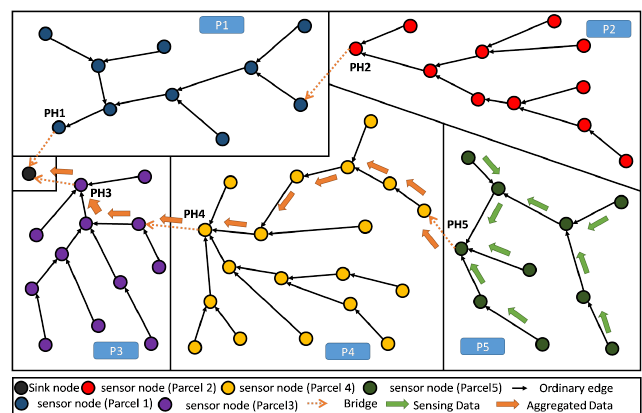
Figure 11. PA-RPL DODAG: collection and aggregation of homogeneous data at parcel